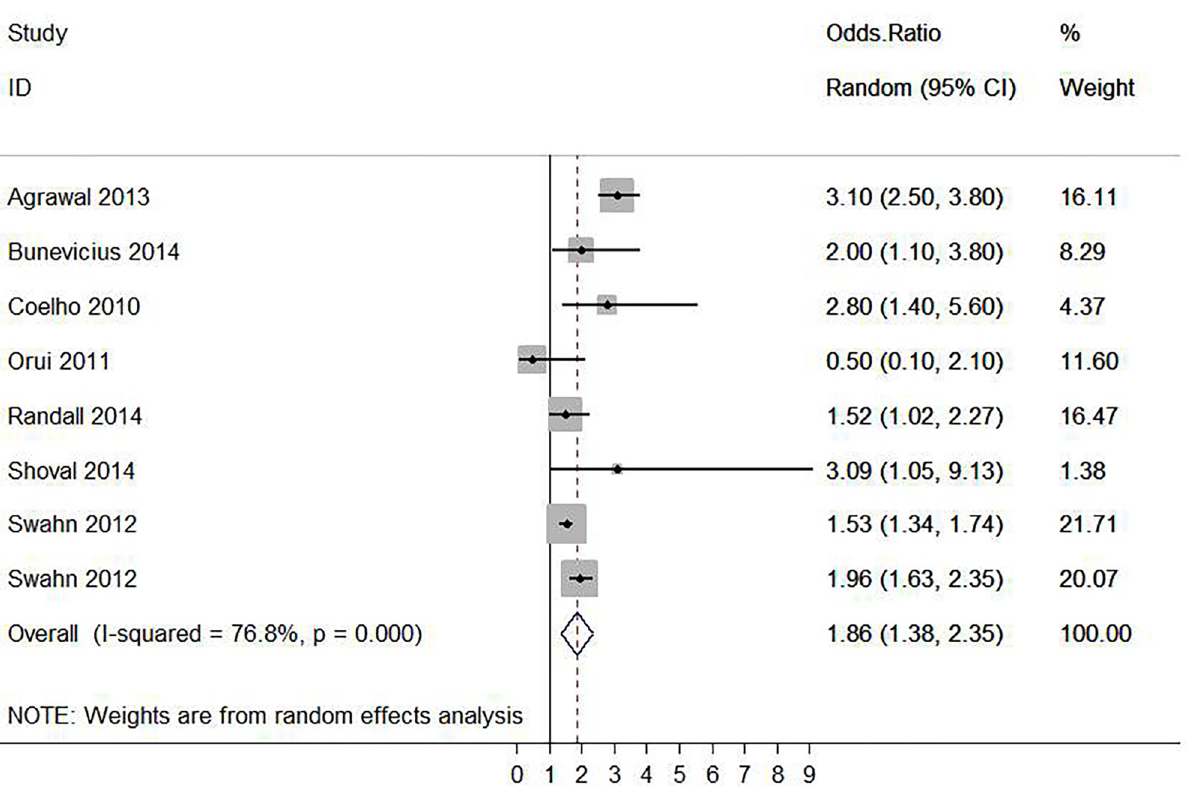
Fig 2. Forest plot of the association between alcohol use disorder and suicide ideation.